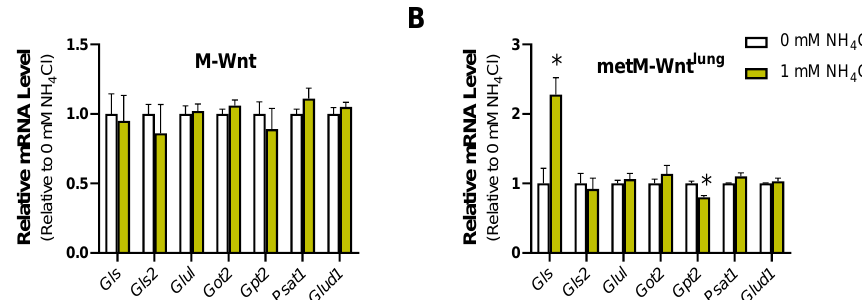
Figure 5. Effect of ammonium chloride treatment on mRNA abundance. Relative mRNA level was determined by qRT-PCR in ( A ) M-Wnt and ( B ) metM-Wnt lung cells grown in 2 mM glutamine with 1 mM ammonium chloride (NH 4 Cl) or sodium chloride (Ctrl) for 48 h. Results are expressed as means + SEM. Asterisk (*) p < 0.05 relative to Ctrl.